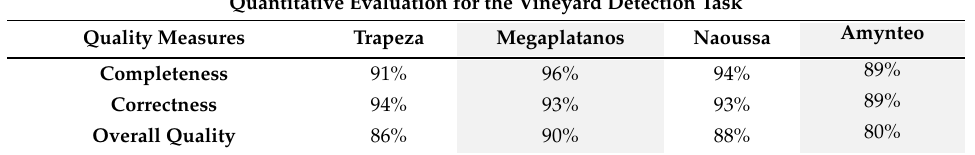
Table 2. The developed framework managed in all cases to detect vineyards with high detection rates; completeness and correctness rates stayed above 89% in all study areas.